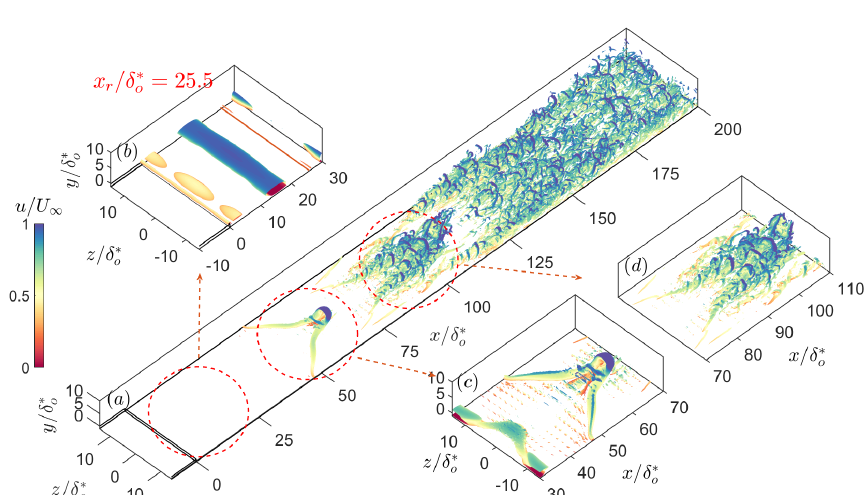
Figure 9. Contours of u (cid:48) rms . ( a ) Large step; ( b ) small step; ( c ) small step, variable U e . ∂ 2 U / ∂ y 2 = 0; ∂ U / ∂ y = 0. Different scales are used on x and y axes.